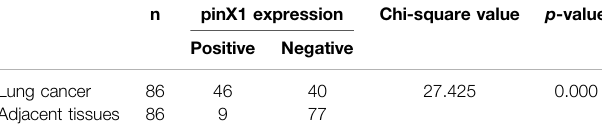
TABLE 2 | Correlation between pinX1 expression and clinicopathological